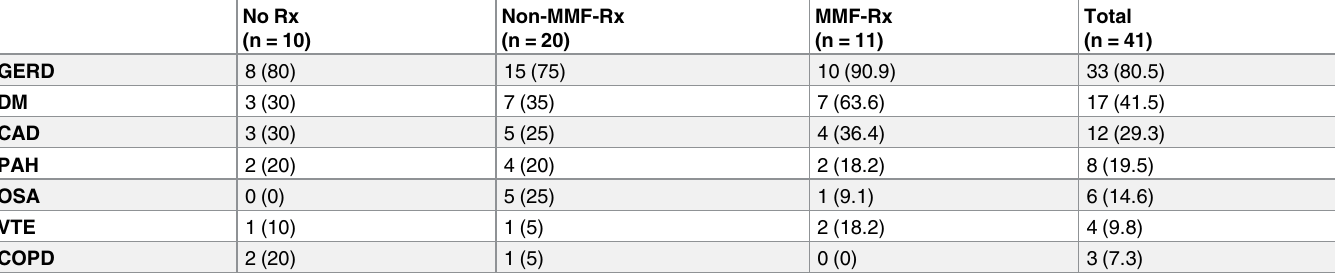
Table 3. Comorbidities (ordered by